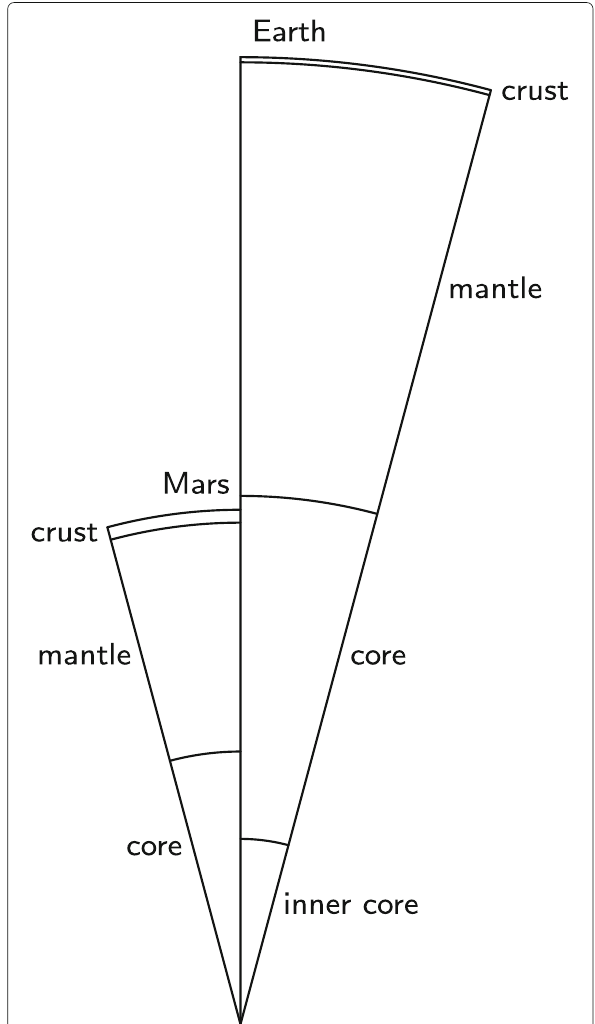
Fig. 1 Comparison of sizes and interior features of Earth and Mars. Mars is almost a half-size scale model of the Earth, except for its thicker crust (Rivoldini et al. 2011) and its probable absence of an inner